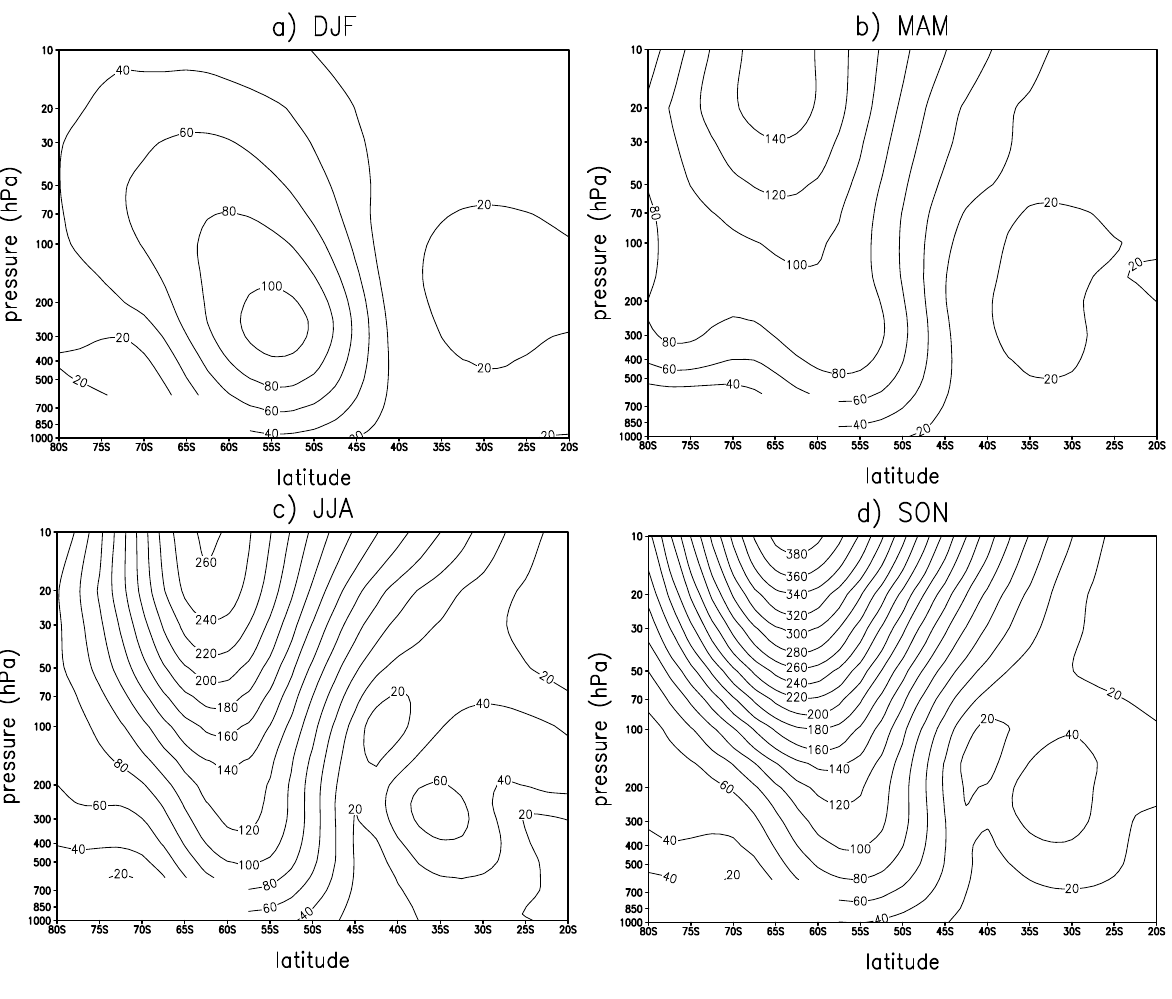
Fig. 1. Amplitudes of QS wave 1 (m) in the data set for the period 1950–1998 for: (a) DJF, (b) MAM, (c) JJA and (c) SON. Contour interval is